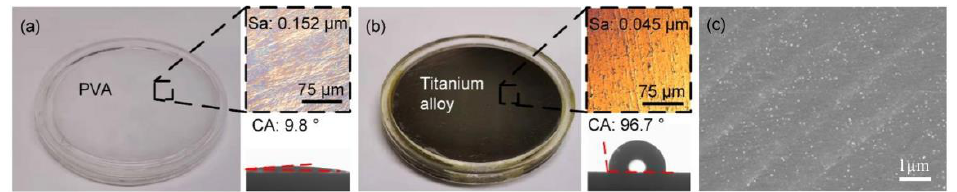
Figure 1. Confocal maps of the smooth titanium alloy and of the hydrogel as well as smooth surface morphology. Surface morphology of ( a ) the hydrogel and ( b ) the titanium alloy. ( c ) the SEM of pol- ished titanium alloy.